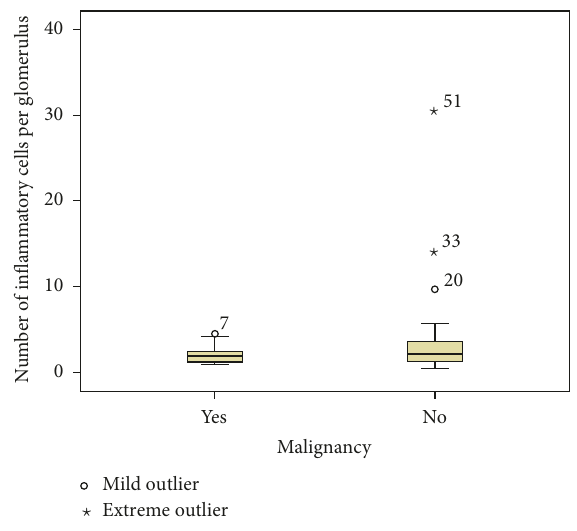
Figure 2: The median number of inflammatory cells per glomerulus in patients with and without